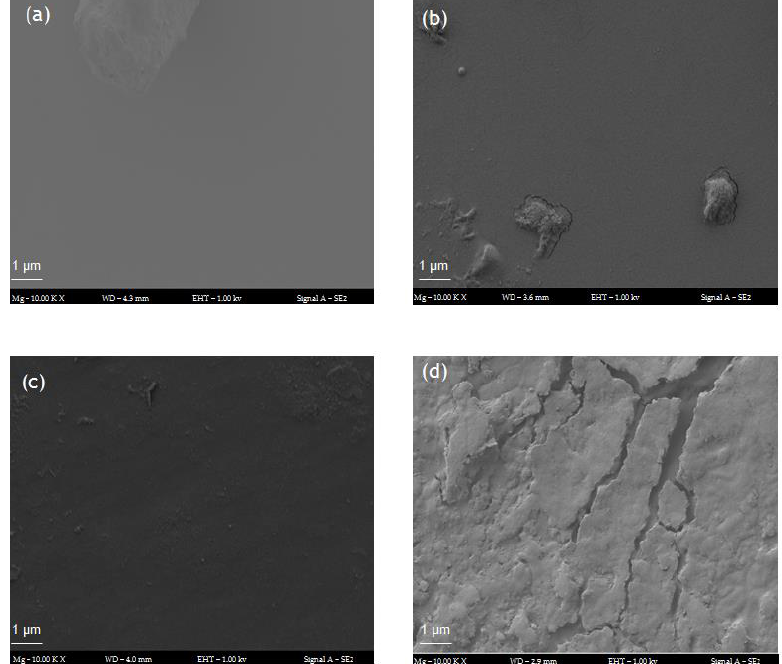
Figure 11. FESEM micrographs of the PU synthesized with P.2-3%Ch-15%PCL after the degradation process in different media (10,000×). ( a ) Undegraded material; ( b ) Acidic medium (0.1 M HCl) after 90 days; ( c ) Basic medium (0.1 M NaOH) after 90 days; ( d ) Enzyme medium (esterase) after 21 days.